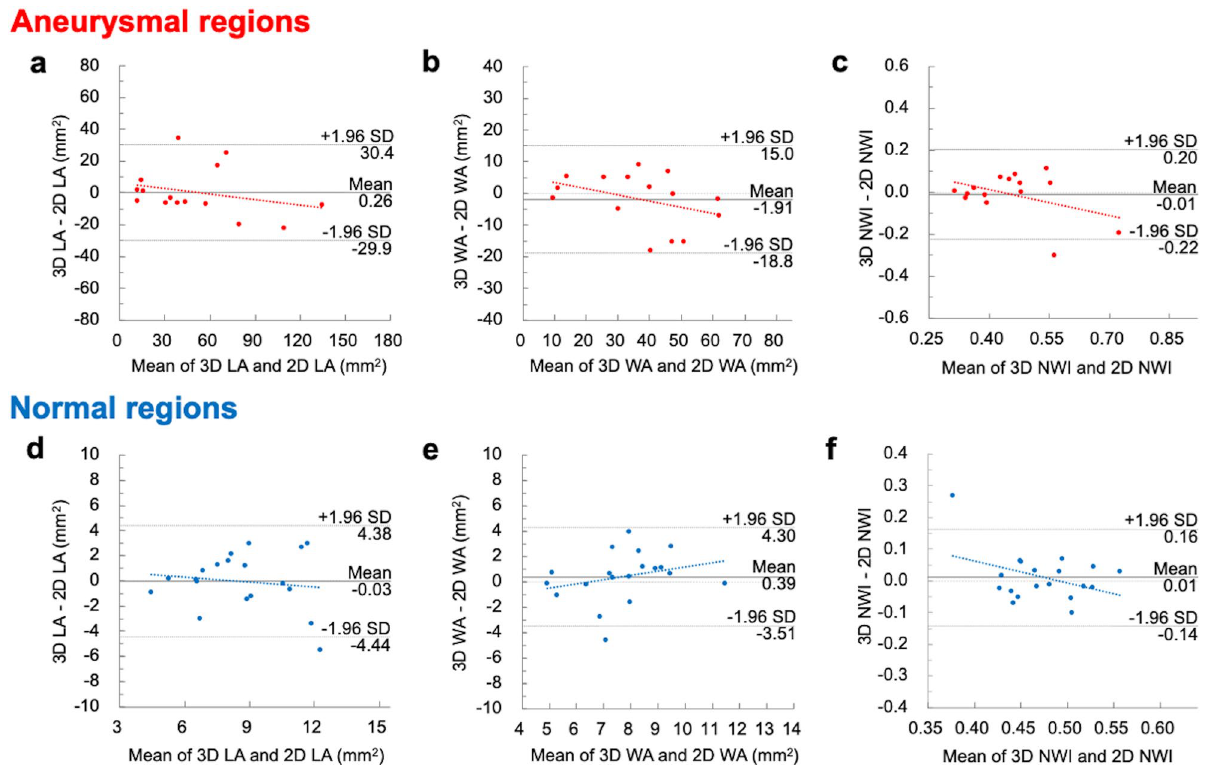
Figure 5. Bland–Altman plots of the LA, wall area WA, and NWI, determined by three-dimensional turbo spin-echo (3D-TSE) and 2D-DIR-TSE images in aneurysmal ( a–c ) and normal ( d–f ) regions. Bland–Altman plots demonstrate good agreement between 3D-TSE and 2D-DIR-TSE images. In the aneurysmal region, there are no fixed biases in LA, WA, and NWI ( P = 0.948, 0.407, and 0.736, respectively). There are no proportional biases in LA, WA, and NWI ( P = 0.334, 0.167, and 0.136, respectively). Similarly, in the normal regions, there are no fixed biases in LA, WA, and NWI ( P = 0.956, 0.399, and 0.540, respectively). There are no proportional biases in LA, WA, and NWI ( P = 0.600, 0.259, and 0.105, Table 3 outlines the inter-reader and intra-reader reproducibility results. The inter- and intra-reader ICCs of all area measurements were > 0.8, thus indicating excellent reproducibility. We observed high ICCs between 3D-TSE and 2D-DIR-TSE images in the LA and WA (LA, 0.95; WA, 0.95). Figure 5 depicts the Bland–Altman plots of the LA, WA, and NWI between the 3D-TSE and 2D-DIR-TSE images. The 95% limits of agreement were LA, WA, and NWI of − 29.9 to 30.4 mm 2 , − 18.8 to 15.0 mm 2 , and − 0.22 to 0.20